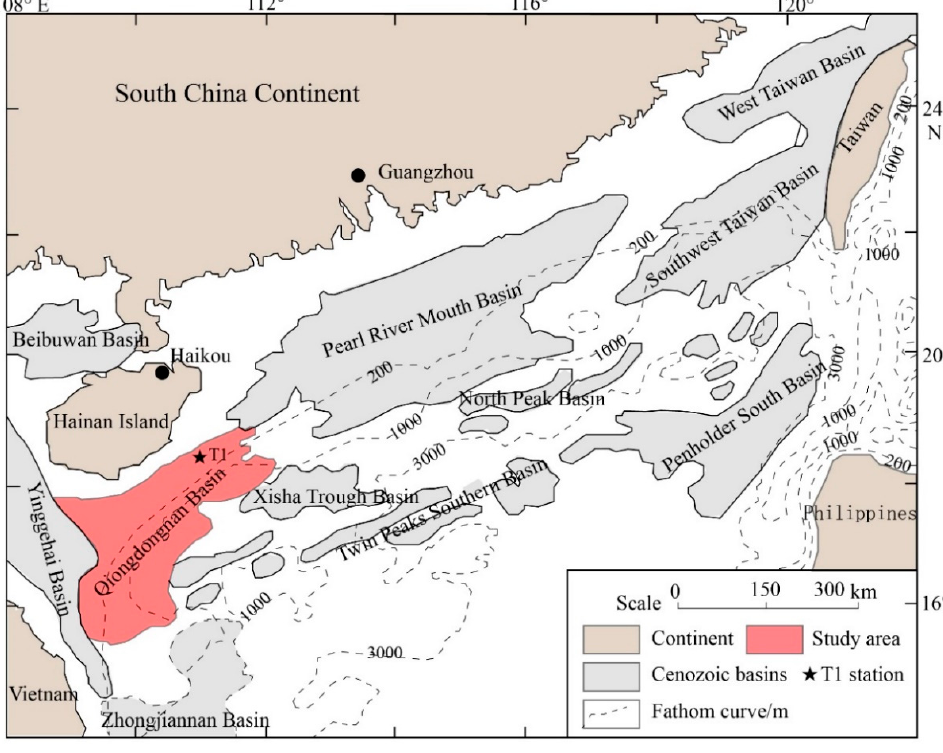
Figure 2. Geographical location of the research area.